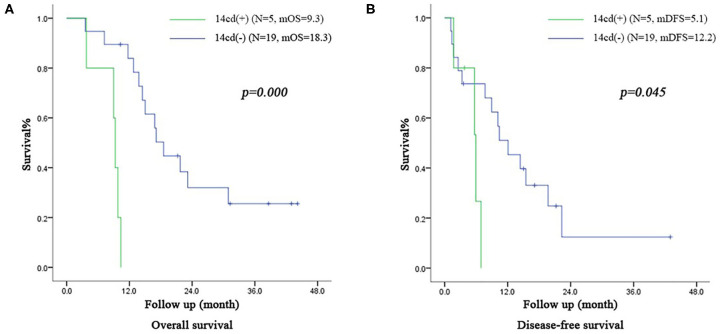
(A) Survival curve of subgroup (patients with IIb stage including LN(+) by direct tumor extension in VE group) according to the LN14cd (±), mOS median overall survival (B) Disease-free survival curve of subgroup (patients with IIb stage including LN(+) by direct tumor extension in VE group) according to the LN14cd (±), mDFS median disease-free survival.